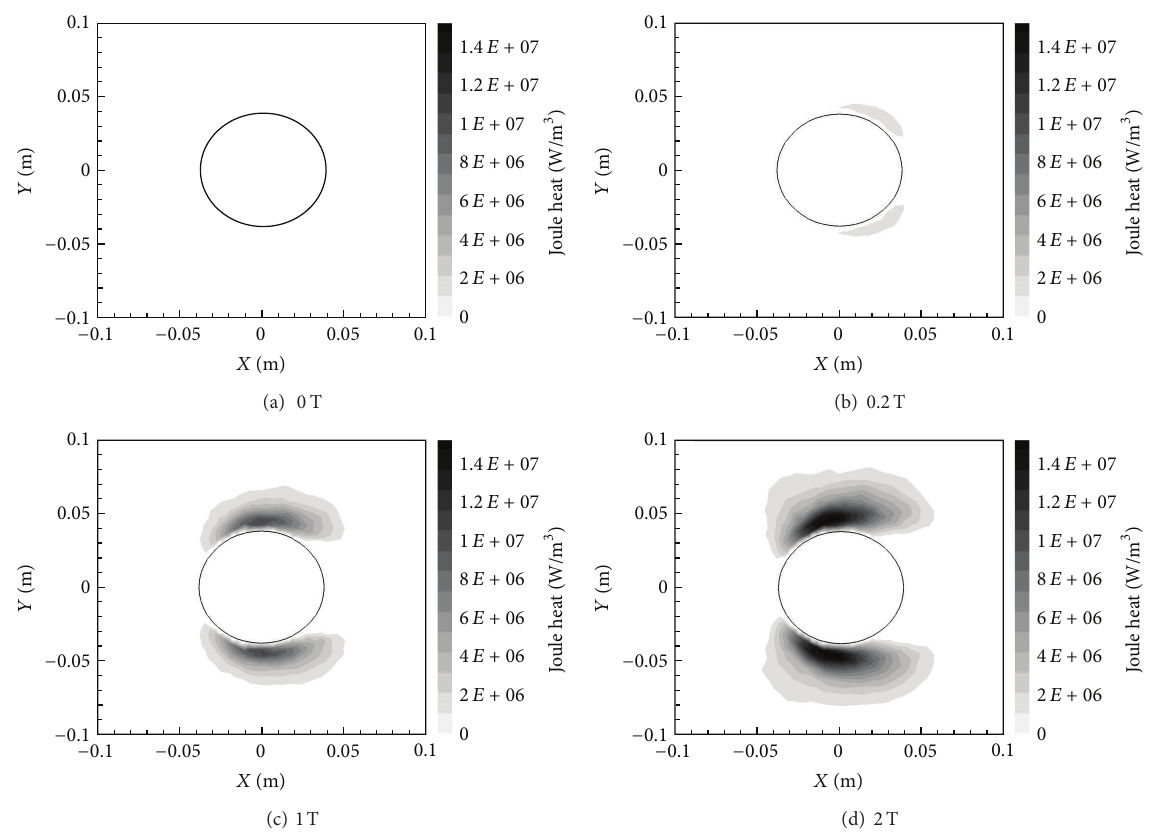
Figure 16: Joule heat contours for various 𝐵 max with 𝑌 -orientation.